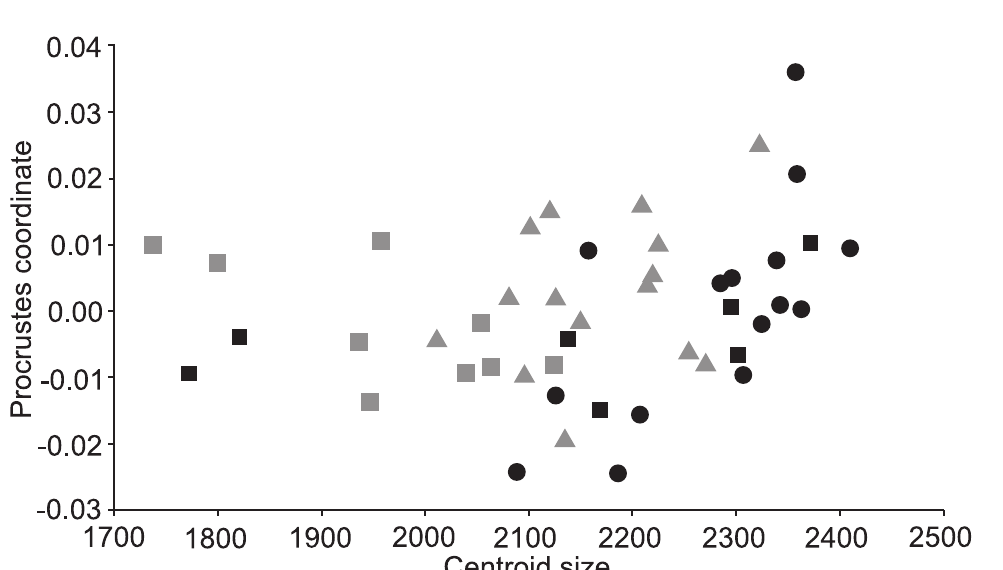
Figure 7. Pooled regression within the two species, between shape (dependent variable) and centroid size (independent variable). Black circles: C. expulsus ; Gray triangle: C. tener ; Black square: Calomys sp. identified as C. expulsus ; Gray square: Calomys sp. identified as C.